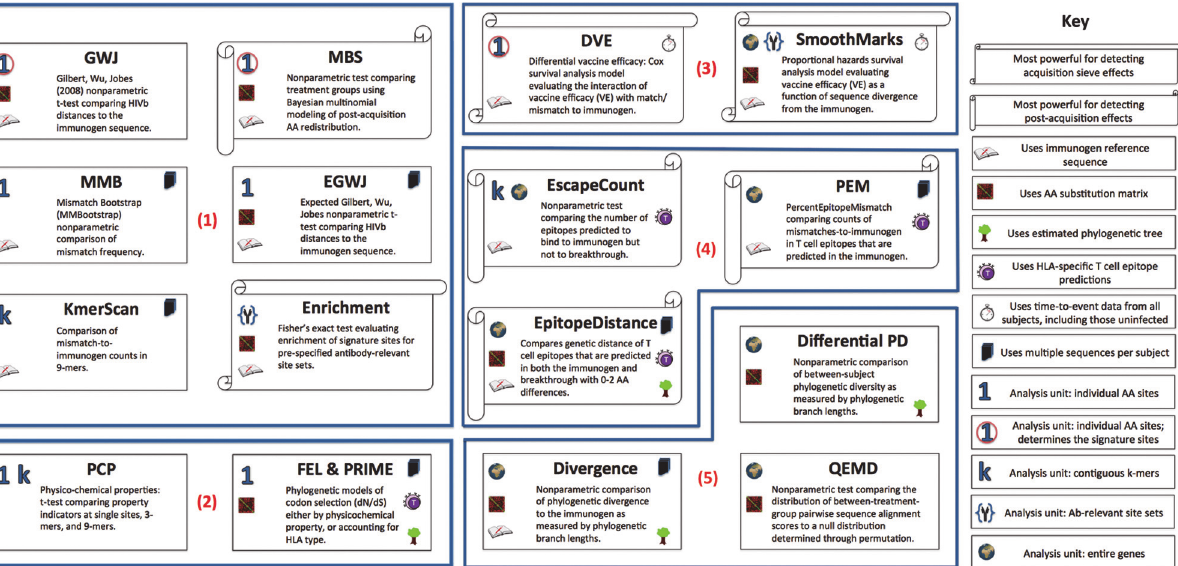
Figure 1. Analysis methods. Methods evaluate (1) differential deviation (vaccine versus placebo) from the immunogen sequences at specific loci or in peptide regions that are relevant to antibody binding; (2) differential codon selection, and differences in physico-chemical properties across vaccine and placebo; (3) differential vaccine efficacy versus HIV-1 sequences that do not match immunogen sequences at individual sites and in each of several pre- specified antibody-relevant protein regions; (4) greater or more rapid viral escape (vaccine versus placebo) at predicted class I and class II HLA-restricted T cell epitopes; and (5) differences in phylogenetic diversity of the breakthrough amino acid sequences (vaccine versus placebo) or differential evolutionary divergence from the vaccine immunogen sequences. T cell and tree images are from openclipart.org.